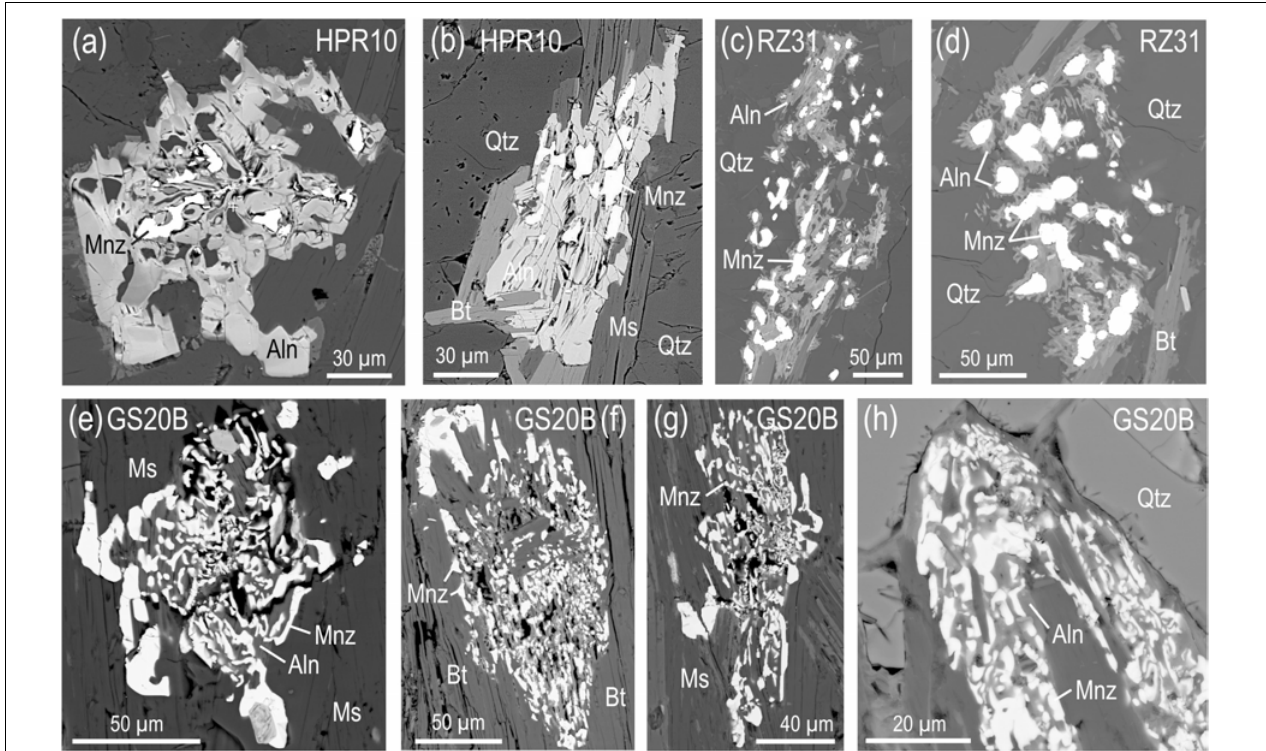
FIGURE 8 | Monazite cluster and symplectite structures. (a,b) Small Cretaceous monazite grains (Mnz) in a polycrystalline aggregate of allanite (Aln) in a micaschist from the Austroalpine Schobergruppe (Krenn et al., 2012). (c,d) Clusters of small monazite grains with mantles of allanite in micaschist from the Oetztal-Stubai Basement (Schulz et al., 2019b). (e-h) Symplectites of monazite and allanite in high pressure low temperature micaschist from the Western Erzgebirge.